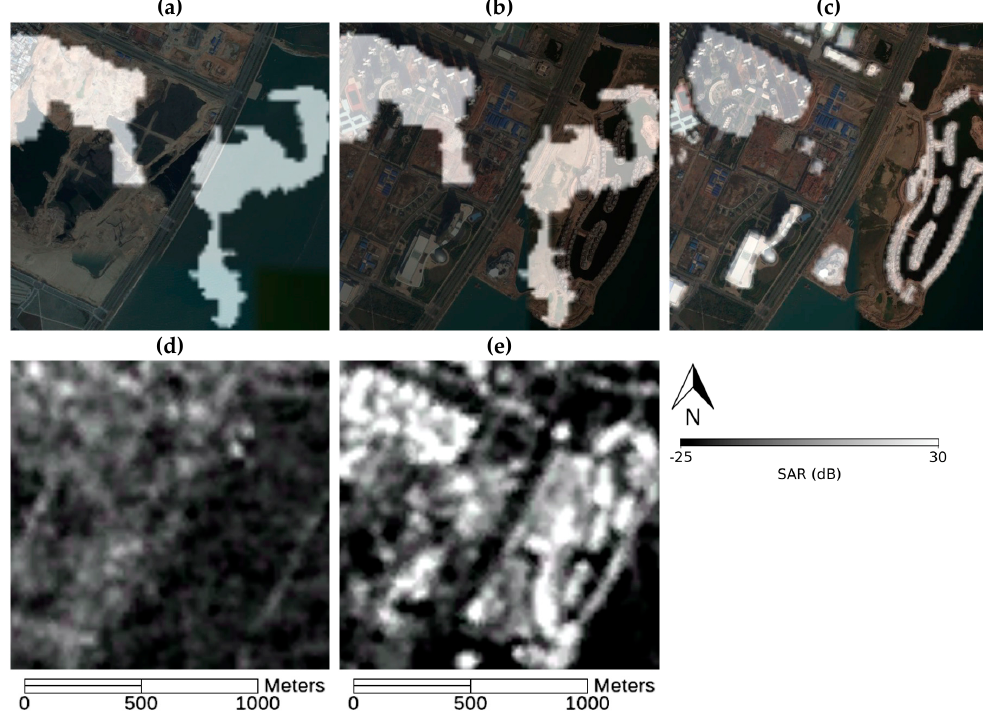
Figure 20. Example of detection results of CORN at Xiamen testing site. ( a ) CORN result overlays on Time 1 optical image, ( b ) CORN result overlays on Time 2 optical image, ( c ) ground truth overlays on Time 2 optical image, ( d ) Time 1 SAR image, ( e ) Time 2 SAR